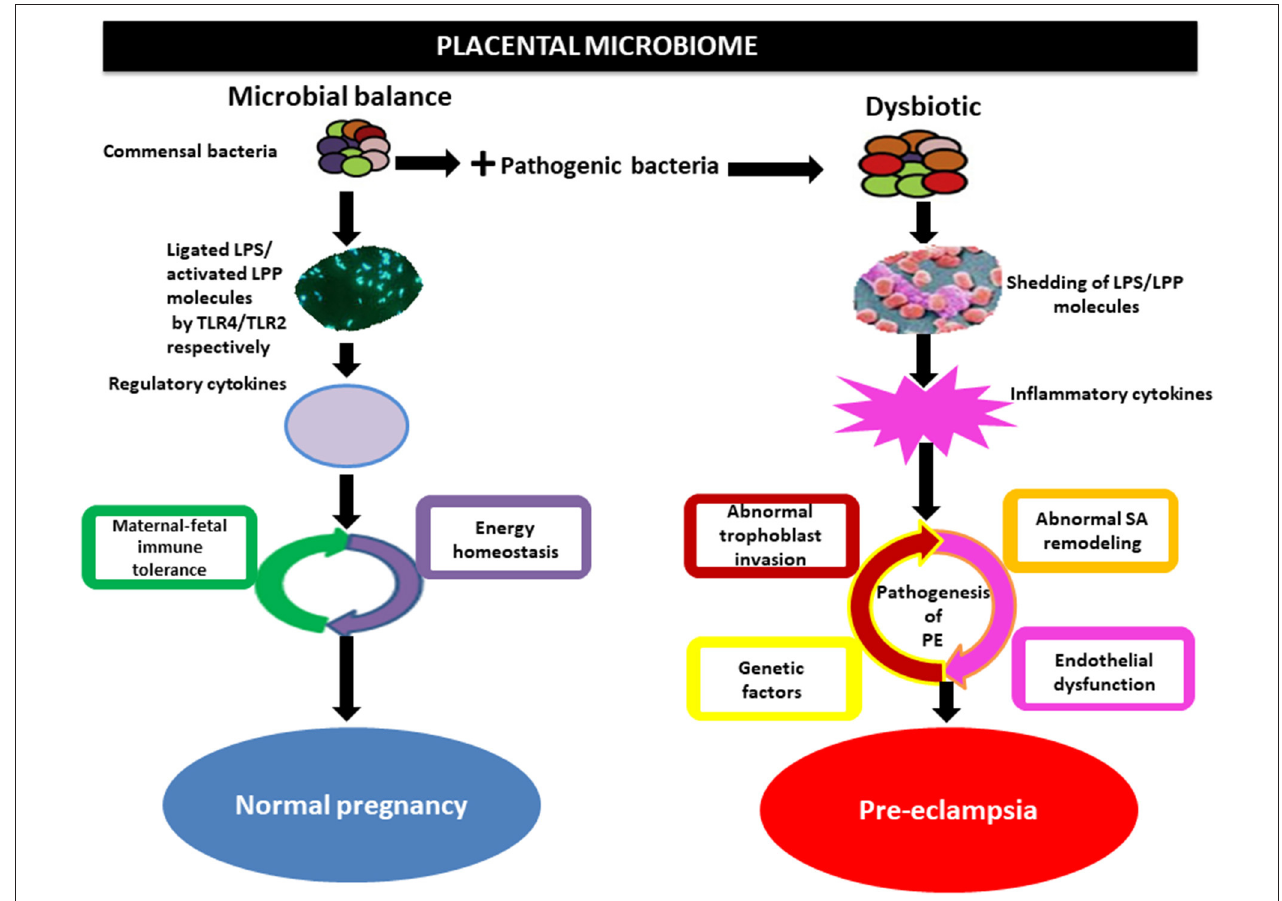
FIGURE 4 | Implication of the placental microbiome in pre-eclampsia. Alteration of placental structures could result from the direct action of pathogenic bacteria through the release of lipopolysaccharide (LPS) or lipoproteins (LPP), which activates inflammatory cytokines via interactions with toll-like receptors (TLRs especially TLR4/TLR2). This invokes the pathogenic process of pre-eclampsia. Whereas, under physiological condition commensal bacteria release bacterial products such as LPS/LPP from gram-negative and positive bacteria, respectively, which is ligated by toll-like receptors (TLR4) and activated by TLR2 located on the surface